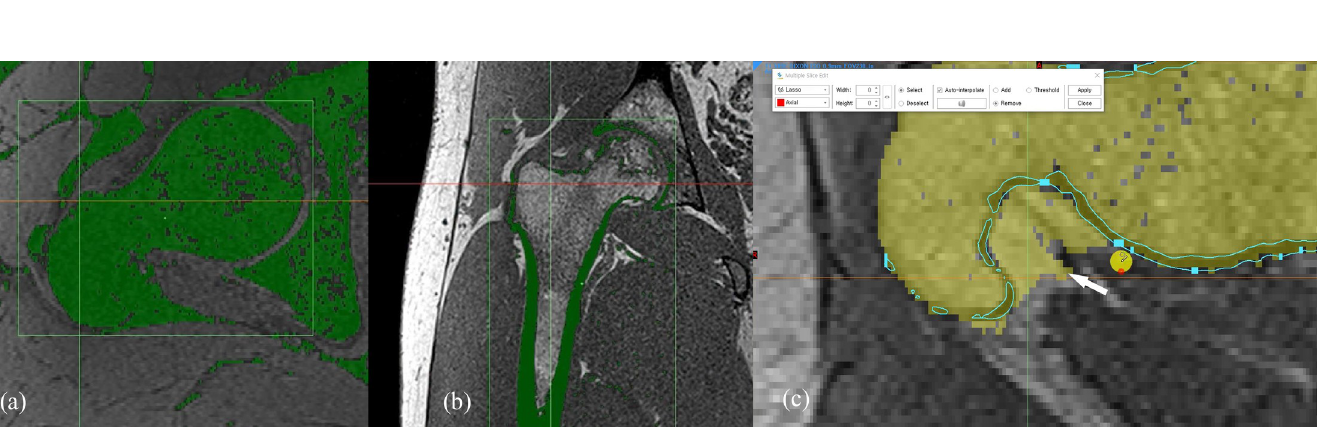
PLOS ONE | https://doi.org/10.1371/journal.pone.0250334 April 30,